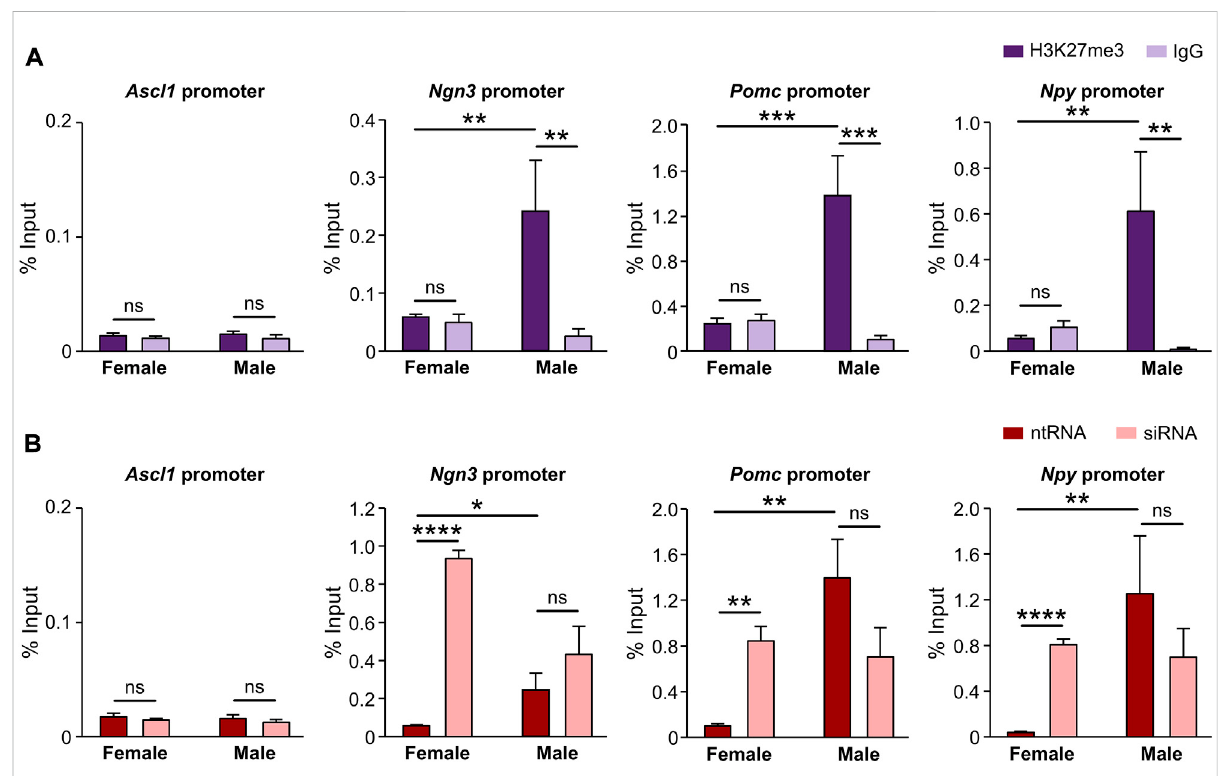
FIGURE 5 Promotersof Ngn3 , Pomc ,and Npy butnot Ascl1 arespeci fi callyregulatedbyKdm6aH3K27me3demethylaseactivity. (A) Levelsof Ascl1 , Ngn3 , Pomc , and Npy promoters DNA bound by H3K27me3 in control hypothalamic neurons measured by ChIP-qPCR and expressed as % of input DNA. IgG antibody served as a negative control for H3K27me3 immunoprecipitation. (B) Kdm6a knockdown effect on Ascl1 , Ngn3 , Pomc , and Npy promoters DNA bound by H3K27me3 in male- and female-derived hypothalamic neurons transfected with a control non-targeting siRNA sequence (ntRNA) or siRNA targeting Kdm6a (siRNA). Data are mean ± SEM. n = 3 – 4 independent cultures for each group. ns, not signi fi cant; * p < 0.05; ** p < 0.01; *** p < 0.001; **** p <